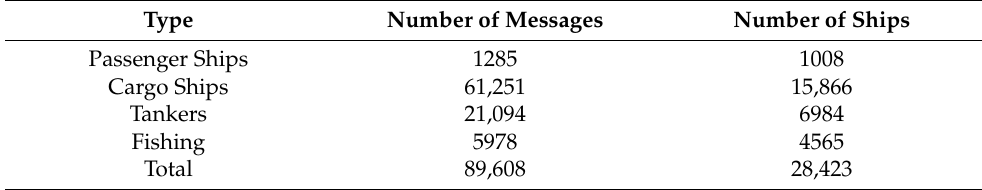
Table 6. The number of static data.